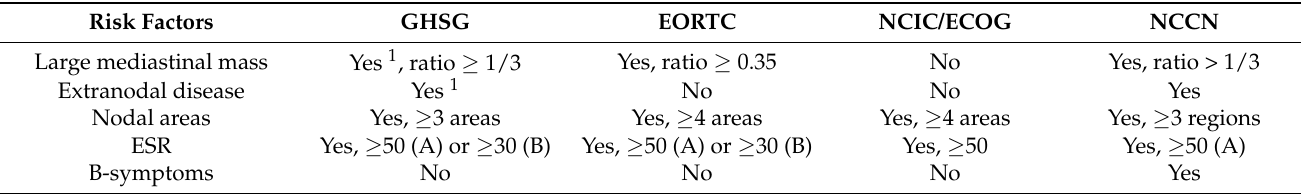
Table 2. Risk factor definitions in Hodgkin’s lymphoma. Patients in CS I–II are staged unfavorable if at least one of the listed risk factors is present